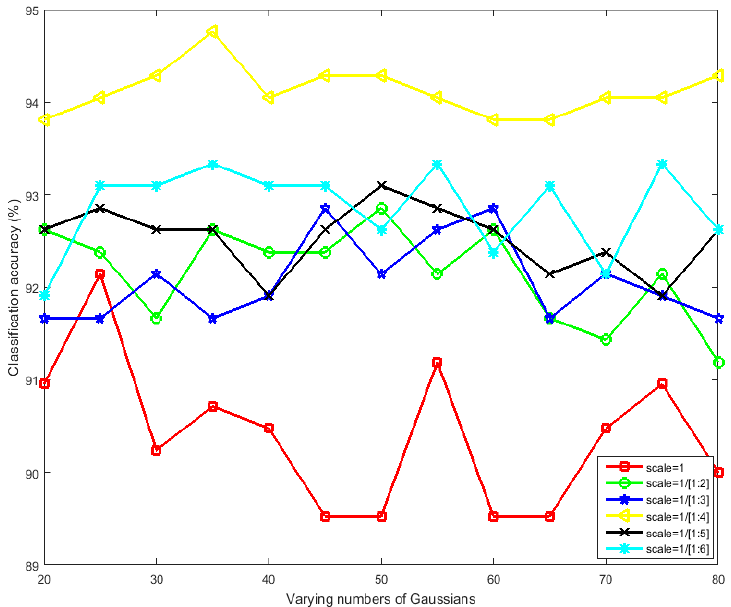
Figure 9. Classification accuracy (%) versus varying numbers of Gaussians and scales for our proposed method for the 21-class land-use dataset.